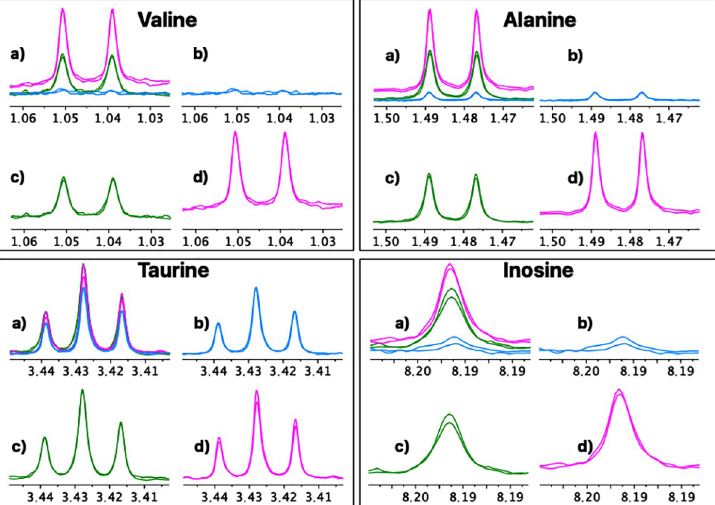
Fig 6. Comparative reproducibility graphical analysis (FM vs. UM vs. UUM) for metabolites Valine, Alanine, Taurine and Inosine. a) Three overlapping methods, b) Folch method, c) Ultrasound and ultrafiltration method, d) Ultrasound method. For each method a duplicate spectrum is shown for the same patient but processed on different days.